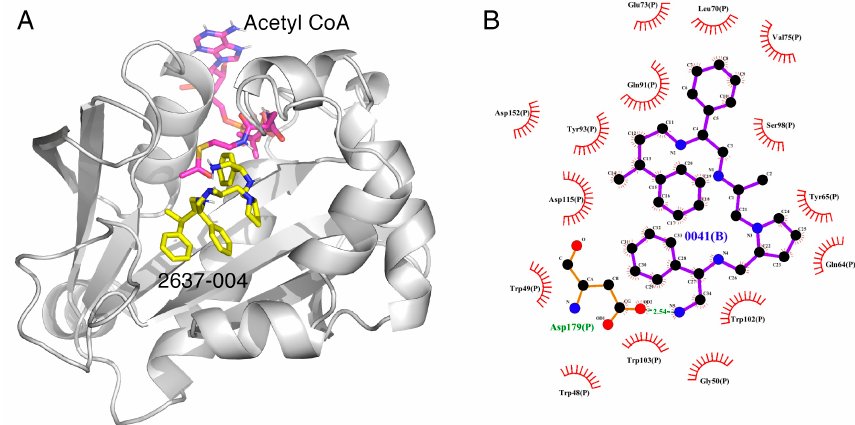
Figure 2. ( A ) The complex of 2637.004 and AAC(6 (cid:48) )-Ib obtained from molecular docking. The bound acetyl CoA is also shown. ( B ) Interaction map of the ligand in its binding site of the AAC(6 (cid:48) )-Ib receptor. The primary amine of 2637.004 maintains a hydrogen bond interaction with Asp179. The pictures show the top-ranked, lowest-energy conformation.